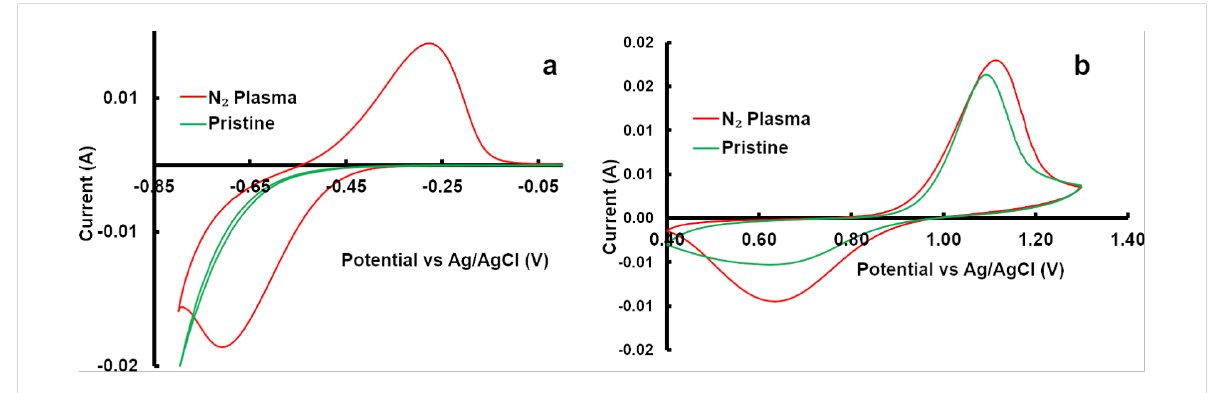
during the N 2 -plasma process also influences the V 3+ /V 2+ redox reaction. This is because the half-cell reaction is known to depend greatly on the carbon edge sites [25]. Another reason for the enhanced activity of the N 2 -plasma-treated samples towards the V 3+ /V 2+ reaction is that the aliphatic carbonaceous materi- als on the surface of the felts are removed